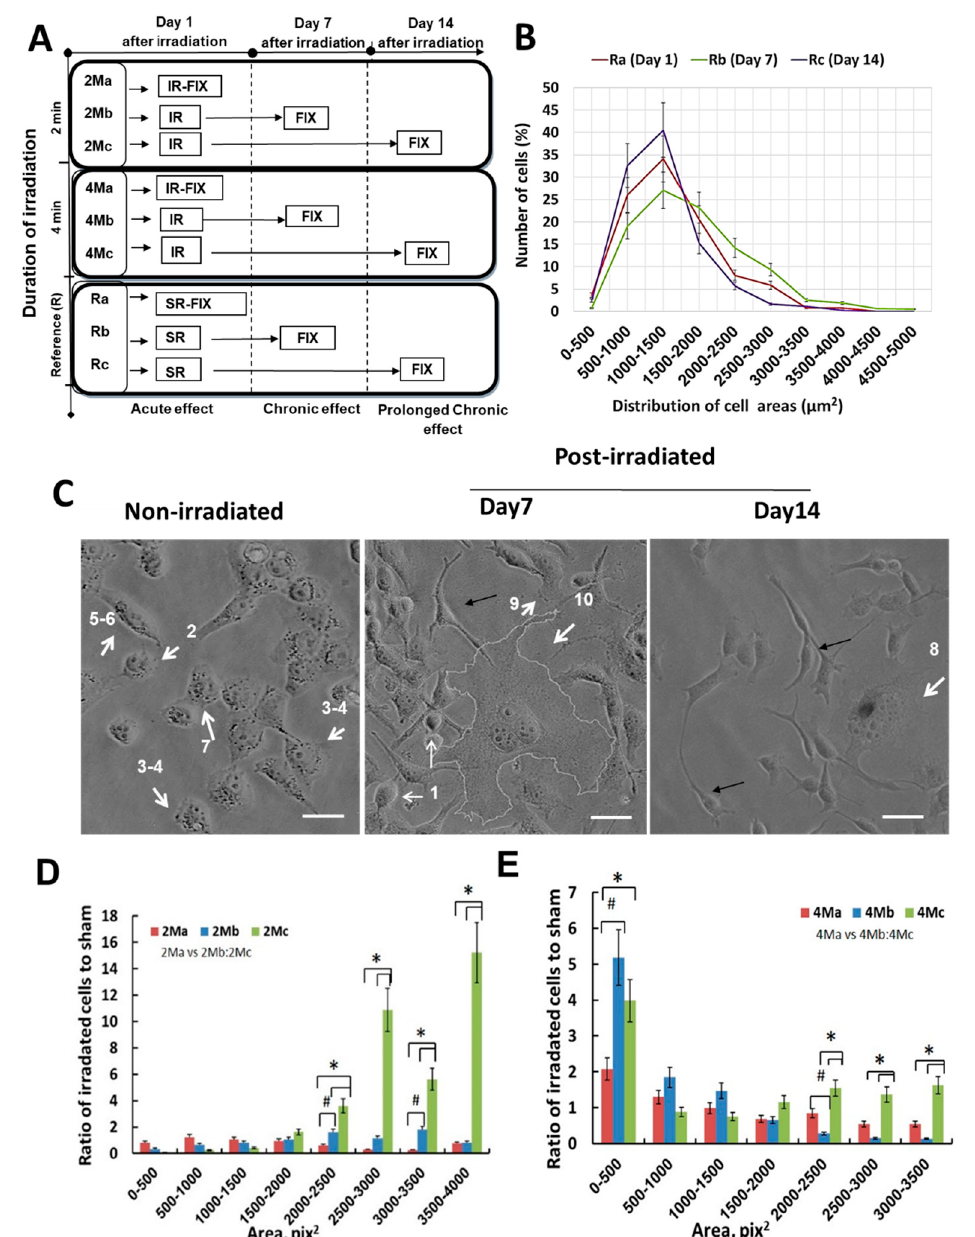
Figure 3. Pictogram of the experimental strategy ( A ), depicting the time schedule and analytical conditions (R—Non-irradiated control retained in the incubator, 2M—two minutes, 4M—four minutes. IR—irradiation, SR—Control cells that underwent the same procedures as the irradiated cells without being irradiated, IMAGE—Microscopy and image analysis). Cells were irradiated for two minutes (2M) or four minutes (4M). Image analysis was performed on day 1 (short-term, a), day 7 (long-term, b), or day 14 (long-term, c). Controls were assessed at the same time points as the irradiated cells (i.e., Ra, day 1; Rb, day 7; and Rc, Day 14 of the experiment). Quantification of the size distribution of control non-irradiated cell areas ( B ) for day 1 (Ra, red line), day 7 (Rb, green line), and day 14 (Rc, violet line). Cell areas were grouped into 10 intervals (500 μ m 2 each) and the number of cells in each group counted and examined by microscopic observation followed by image analysis of cell sizes using the ImageJ program. The observations demonstrate non-significant changes amongst